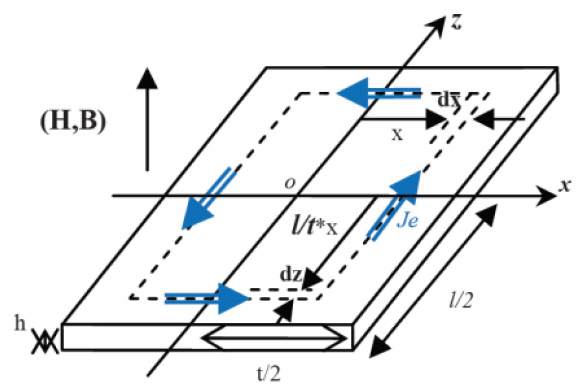
Figure 21. Scheme used for the calculation of eddy currents losses in a conductor sheet in case of neglected skin effect. This means that the thickness of the sheet is small in front of the skin depth.